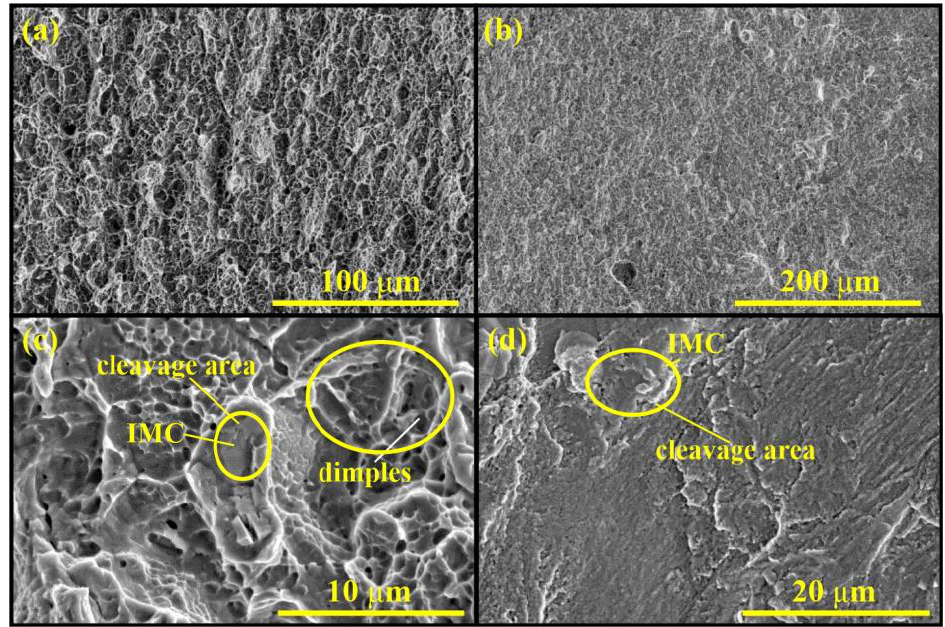
Figure 14. SE images of the fracture surfaces of welded joint after fatigue testing in the upper ( a ), middle ( b , c ), and lower part of the weld ( d ).